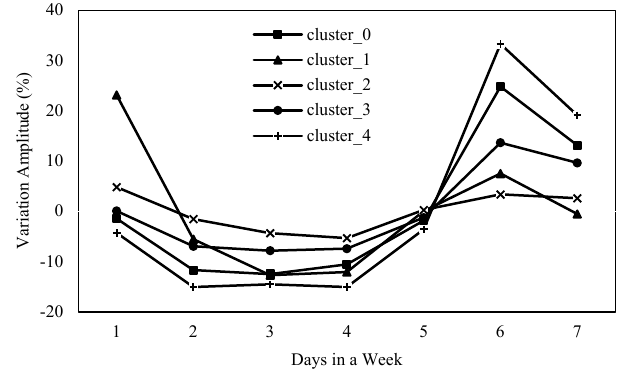
Figure 9. Variation in cluster centers based on immigration.